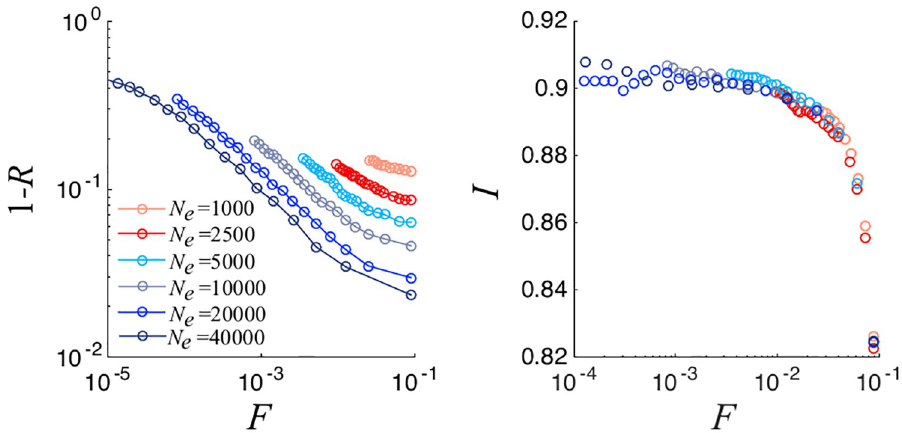
Fig 3. Logarithmic plot of 1 − R versus normalized committee size (left). Mean Committee integrity as a function of normalized committee size (right), for different numbers of electors N 10000, N i = 40 and s 2 ¼ s 2 ¼ 0 : 05 . Results are averaged over 100 different realizations. p